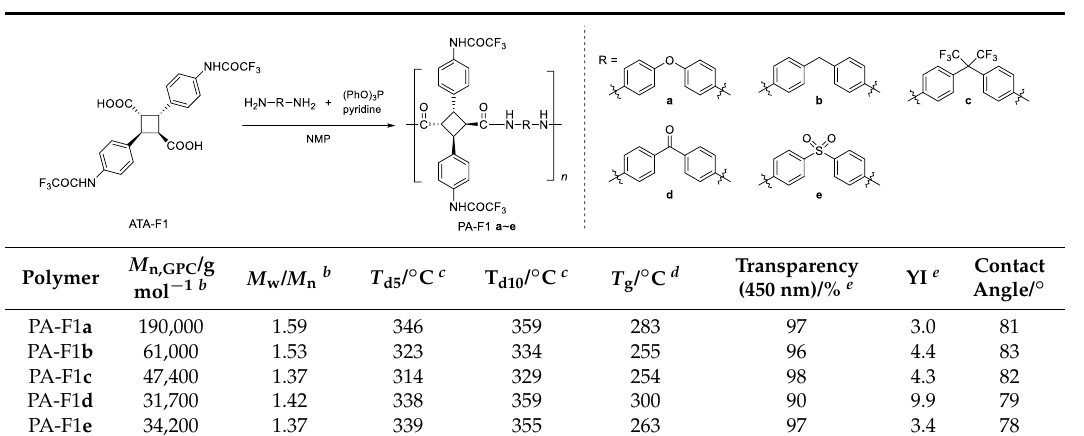
Table 2. Molecular weight, thermal, and optical properties of polyamide (PA-F1 a ~ e ).